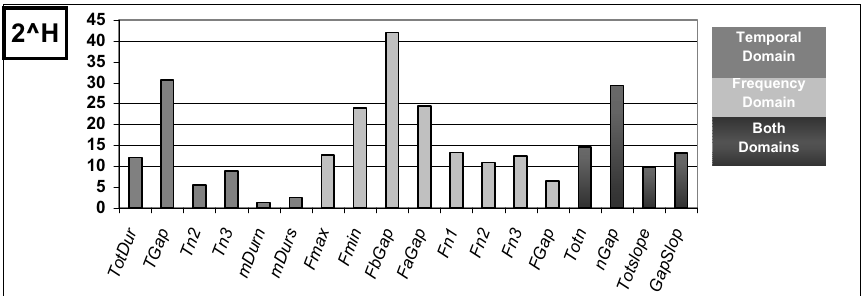
Fig. 4 – Number of individuals that can be potentially discriminated for each of the 18 parameters of the song. Calculation was realized on the basis of the 2 H measure (with H: quantity of information). Higher values are obtained with parameters linked to the main gap: Tgap, FbGap, nGap.